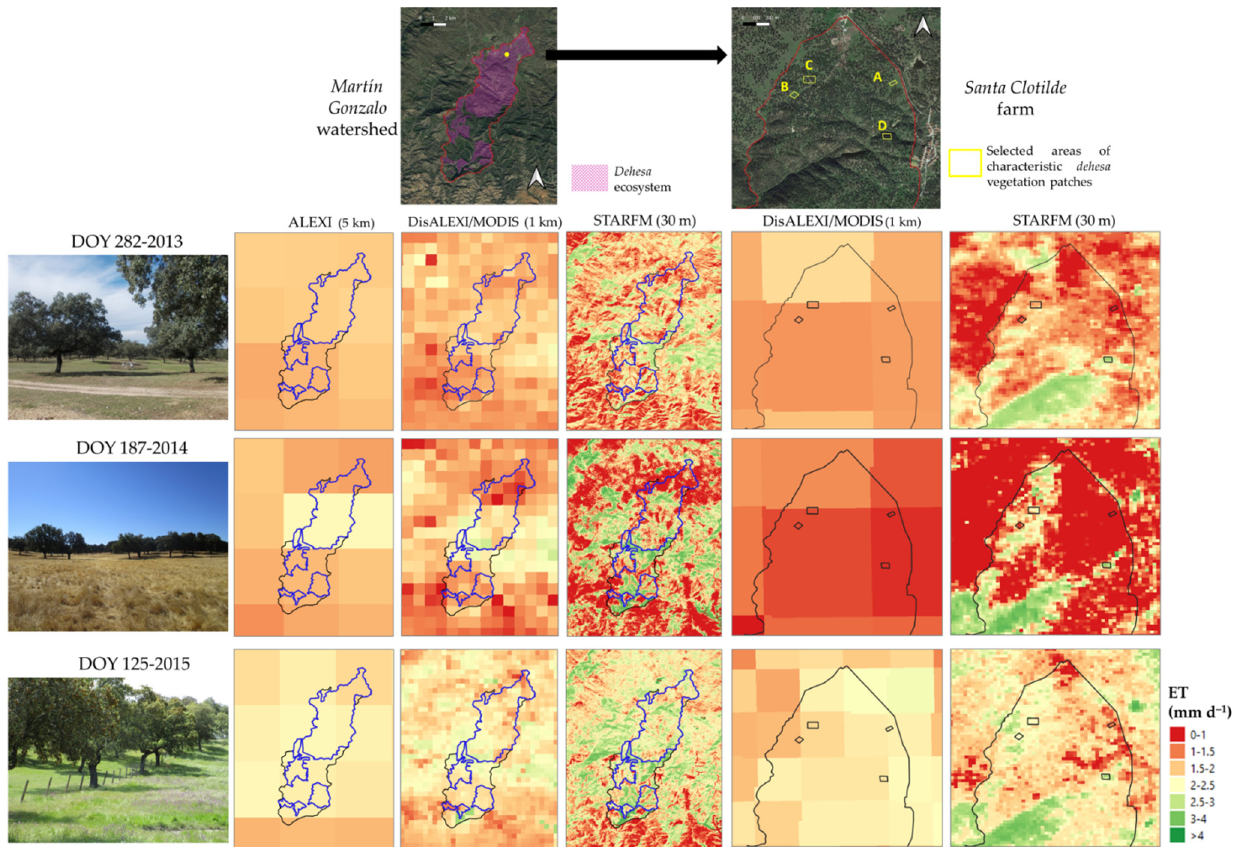
Figure 9. Distributed ET maps over the Martin Gonzalo watershed and Santa Clotilde dehesa farm derived from ALEXI (5 km), the DisALEXI/MODIS application (1 km) and the STARFM approach (30 m) on three representative dates of spring, summer, and autumn seasons. Blue lines show the dehesa ecosystem areas.